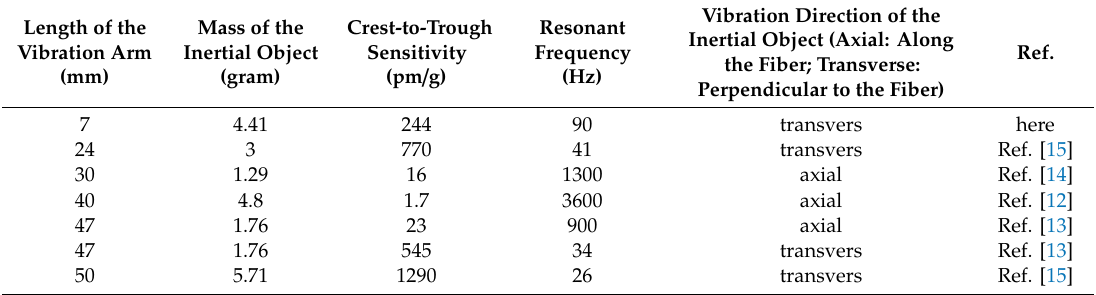
Table 1. Comparison of FBG accelerometers using the optical fiber to hold the inertial object. Length of the Vibration